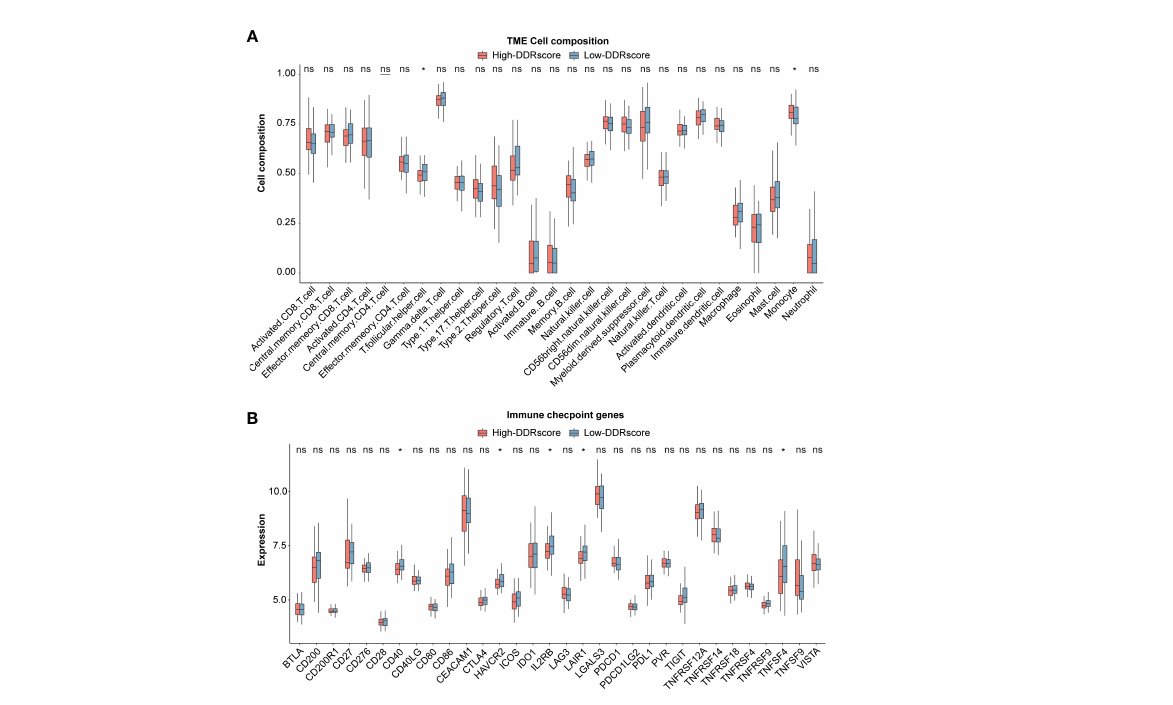
FIGURE 8 Immune analysis between high- and low-DDRscore groups. (A) Boxplot showing the differential abundance of 28 in fi ltrative immune cells calculated by ssGSEA between high- and low-DDRscore groups in the mCRC. (B) Distinct expression of 33 immune checkpoints between high- and low-DDRscore groups in the mCRC. * Indicates P<0.05, ns indicates no signi fi cant difference.